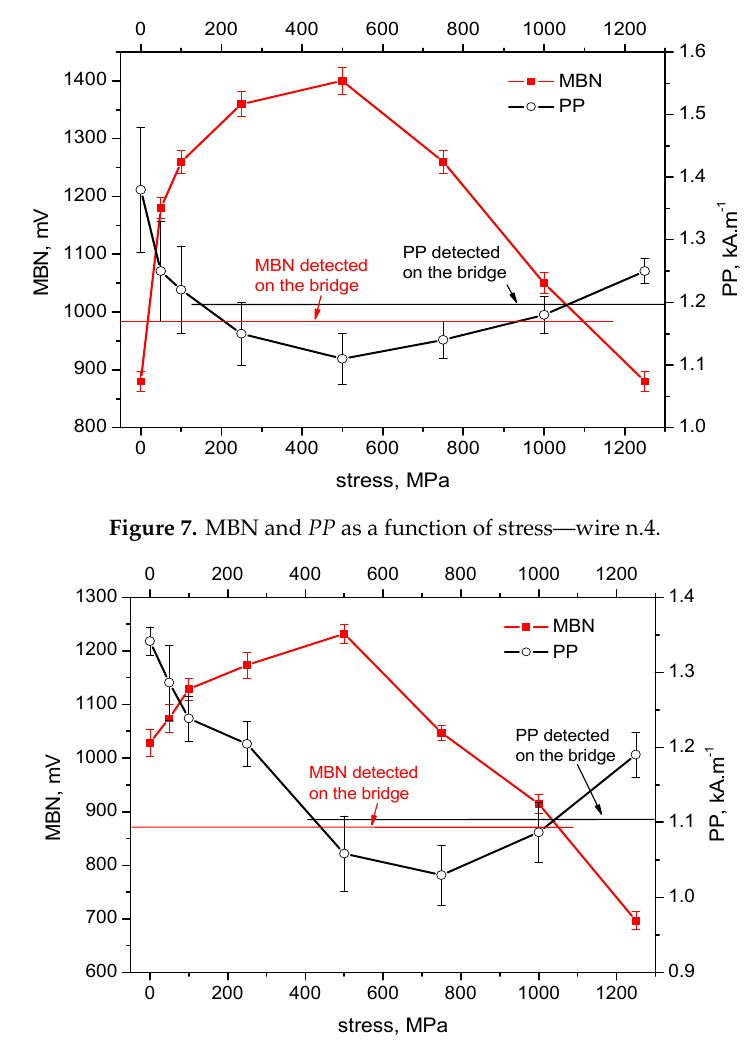
Figure 8. MBN and PP as a function of stress—wire n.5. Materials 2020 , 1 FOR PEER REVIEW